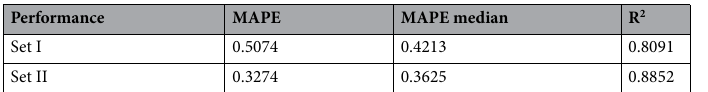
Table 1. Comparison of ANN prediction performance with different variable sets as